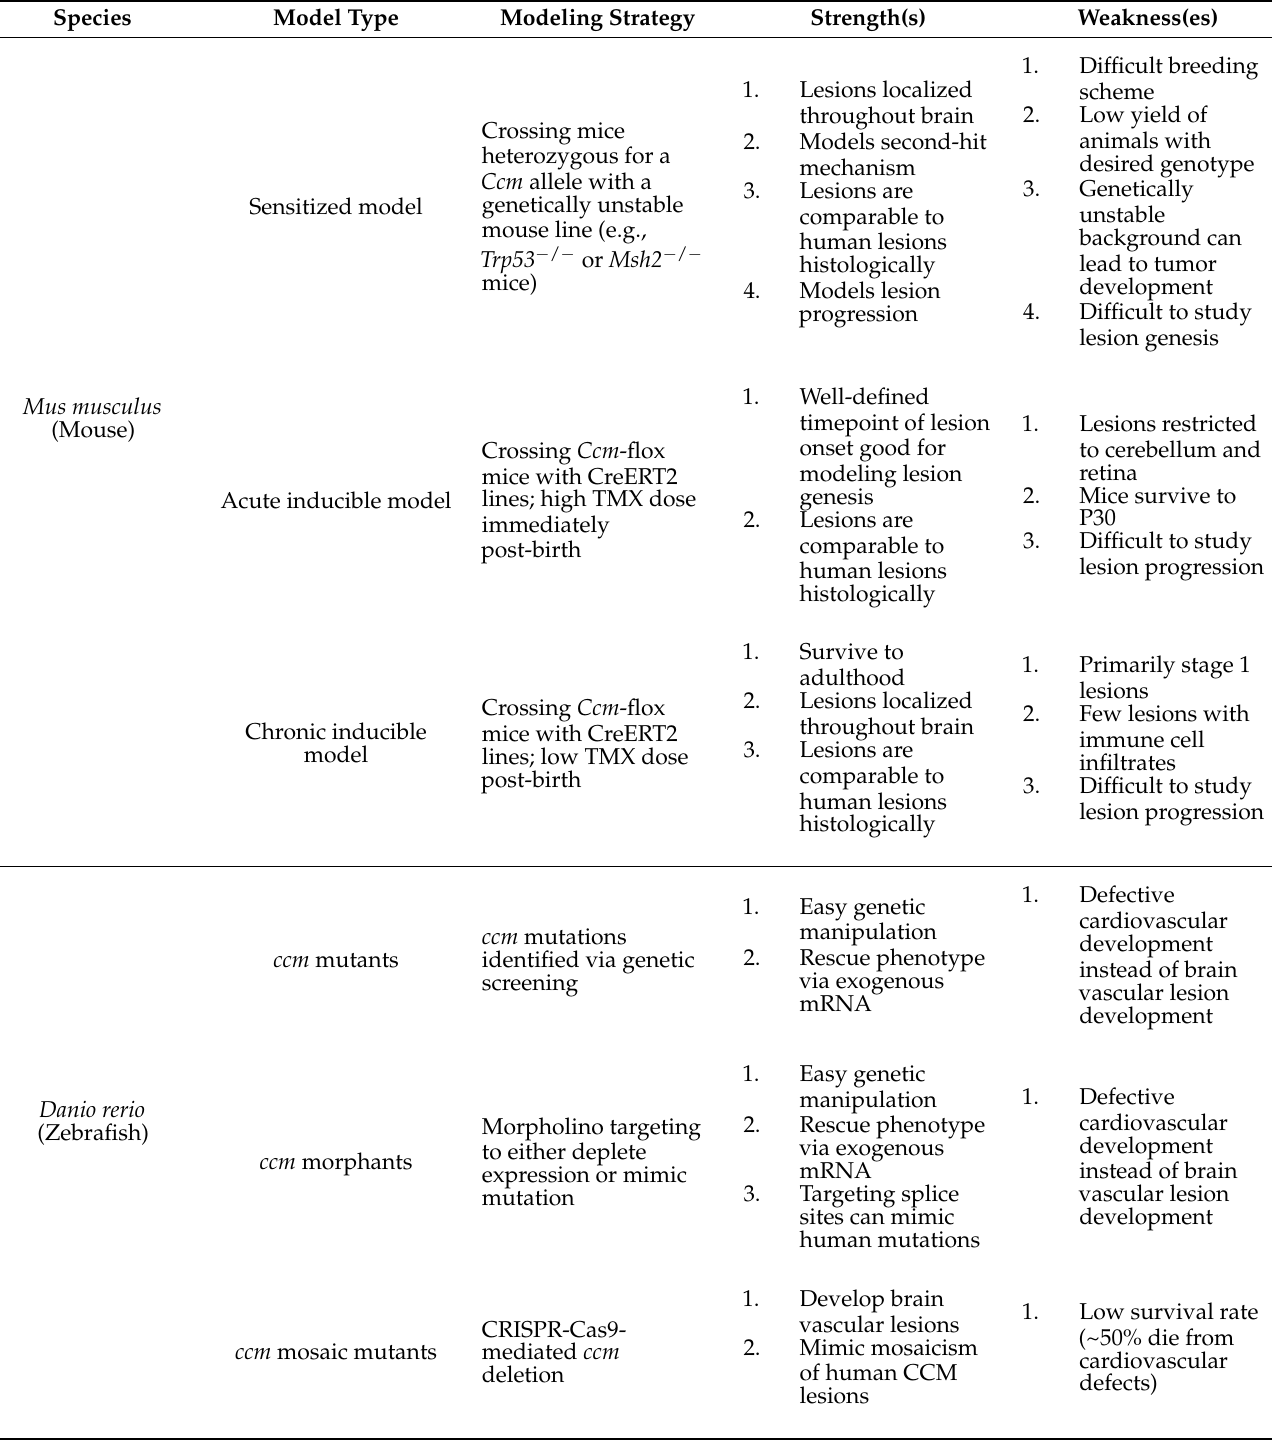
Table 1. A summary of the types of CCM animal models, along with their strengths and